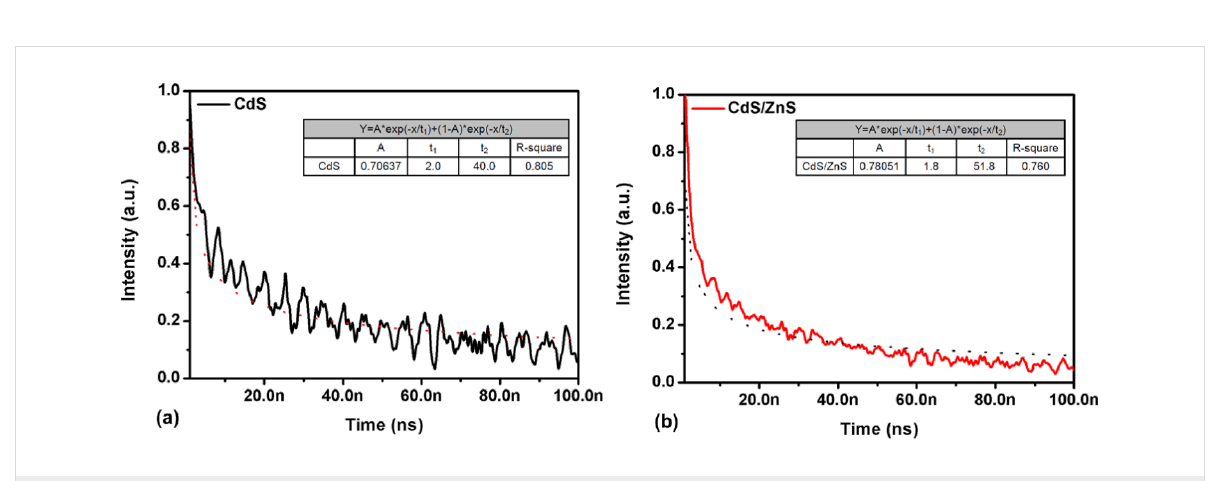
Figure 4: Fluorescence decay curves of (a) CdS and (b) CdS/ZnS QDs.